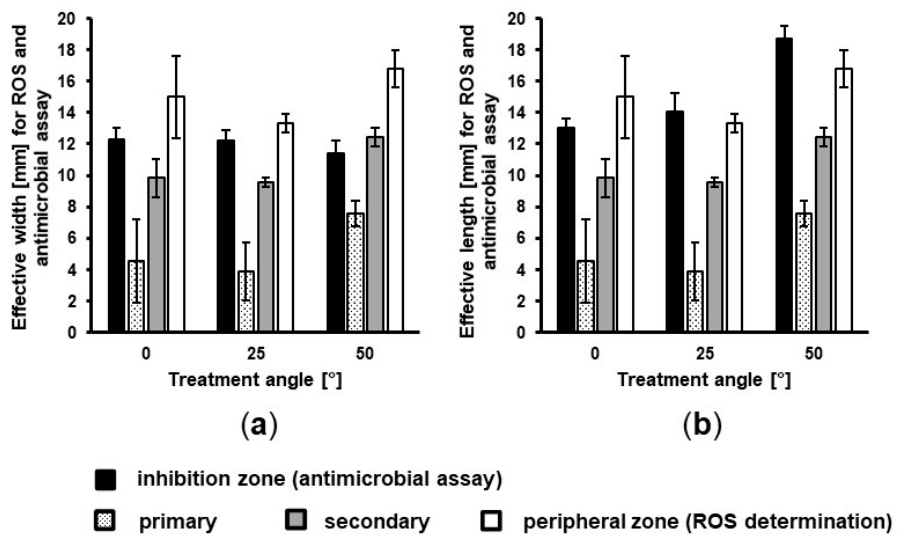
Figure 8. E ff ective ( a ) width and ( b ) length of the inhibition zones in the antimicrobial assay ( Staphylococcus aureus DSM 799 / ATCC 6538, M ± SD, n = 6) and the ROS determination (M ± SD, n = 3) of primary, secondary and peripheral zones depending on incidence angle (0 ◦ , 25 ◦ , 50 ◦ ) after 45 s treatment with kINPen ® MED- β